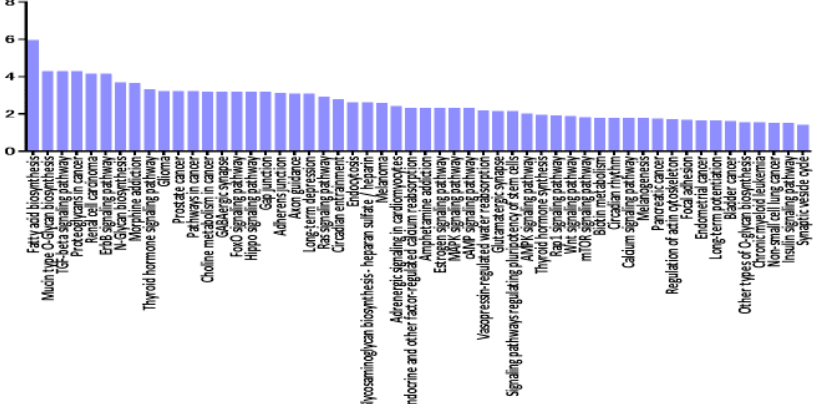
Figure 2. Histogram presenting pathways enriched in genes targeted by VRL-modulated miRNAs and differentially expressed miRNAs in vitreous of VRL patients compared with macular hole/epiretinal membrane patients. y axis: − log 10 ( p -value). TGF: transforming growth factor, ECM: extracellular matrix, FoxO: forkhead box O, Rap: rhoptry-associated protein, AMPK: AMP-activated